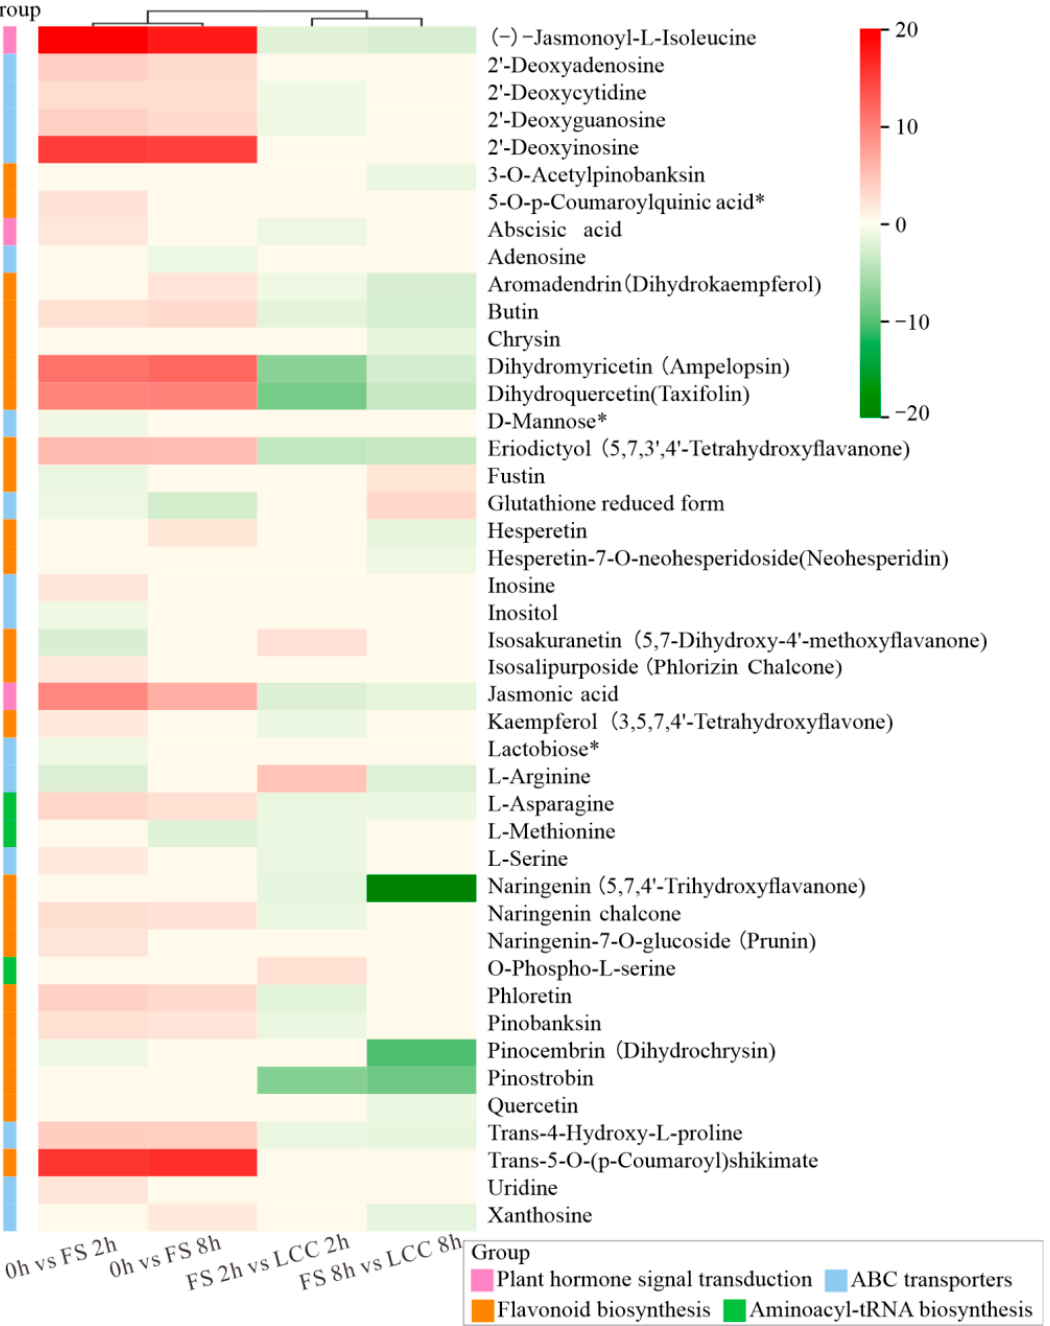
Figure 4. Heat map of Log 2 FC for each differential metabolite reflects the expression between the comparison groups. * in heat map means when using this CAS registry number alone as a research term, it may result in incomplete research results.